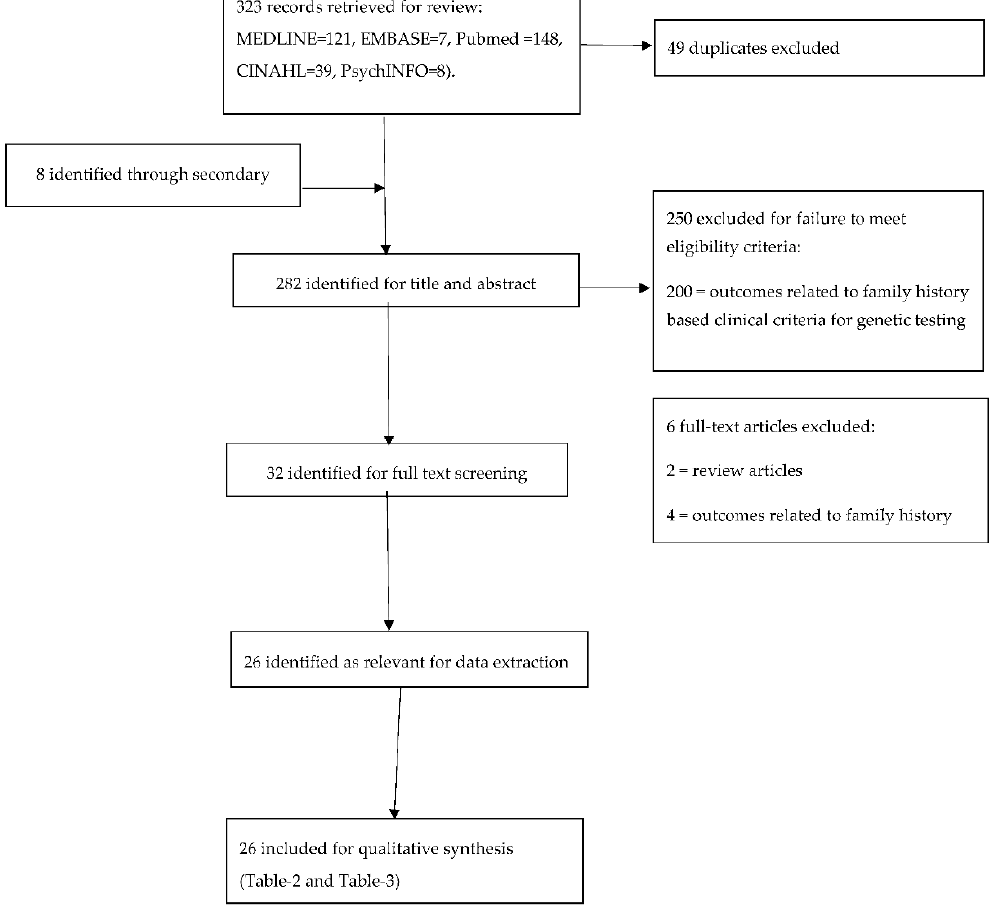
Figure 1. Flowchart of study selection.